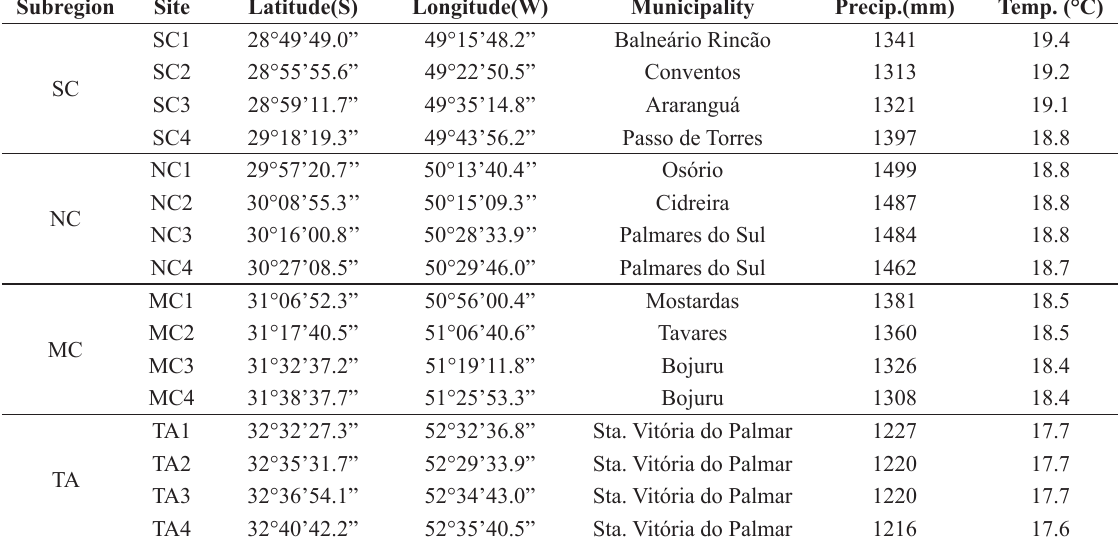
Geographical location and main climatic variables for each of the 16 sample sites in the South Brazilian’s coastal plain. Precipitation and temperature are annual averages for a series of 50 years (Hijmans et al.